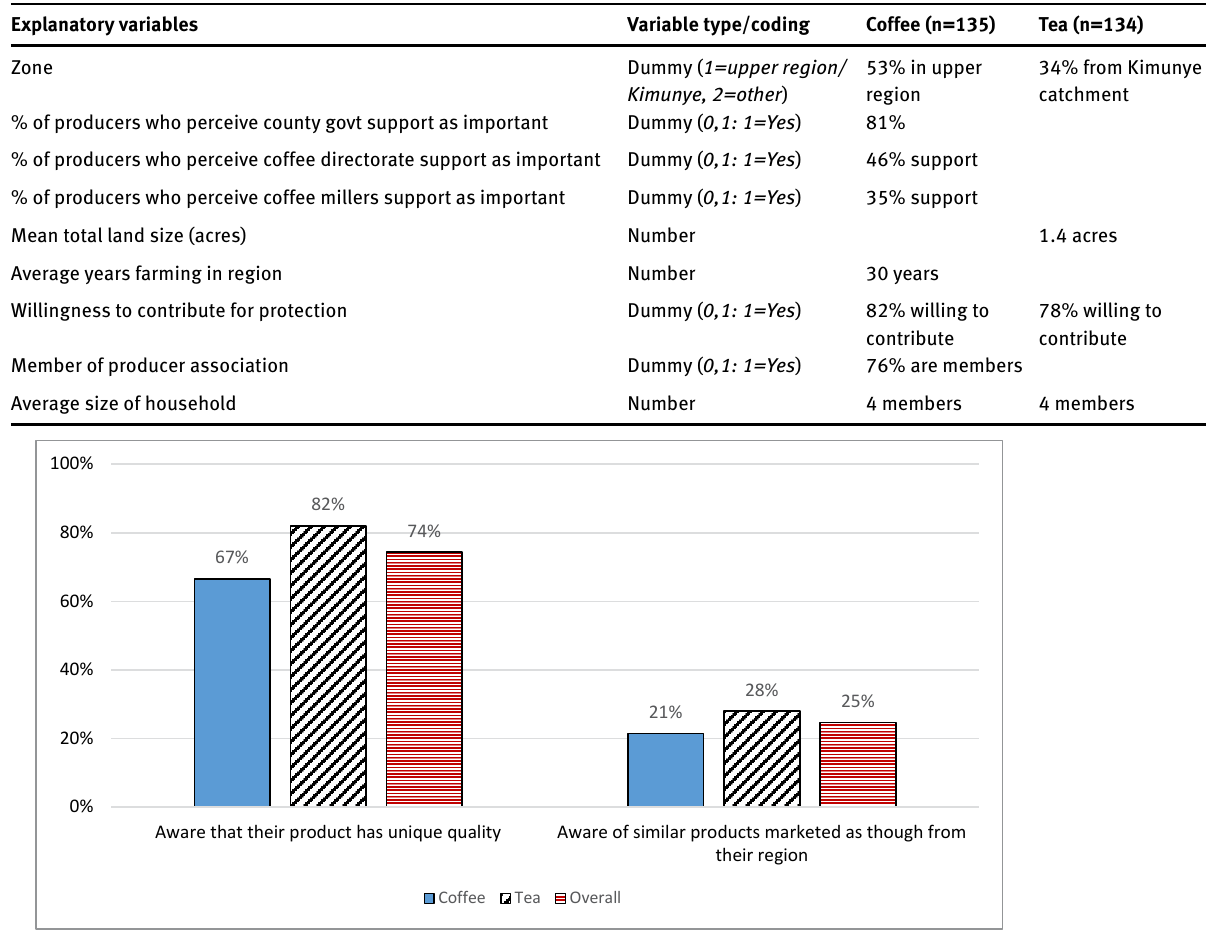
Figure 2: Producers’ awareness of the uniqueness of their respective